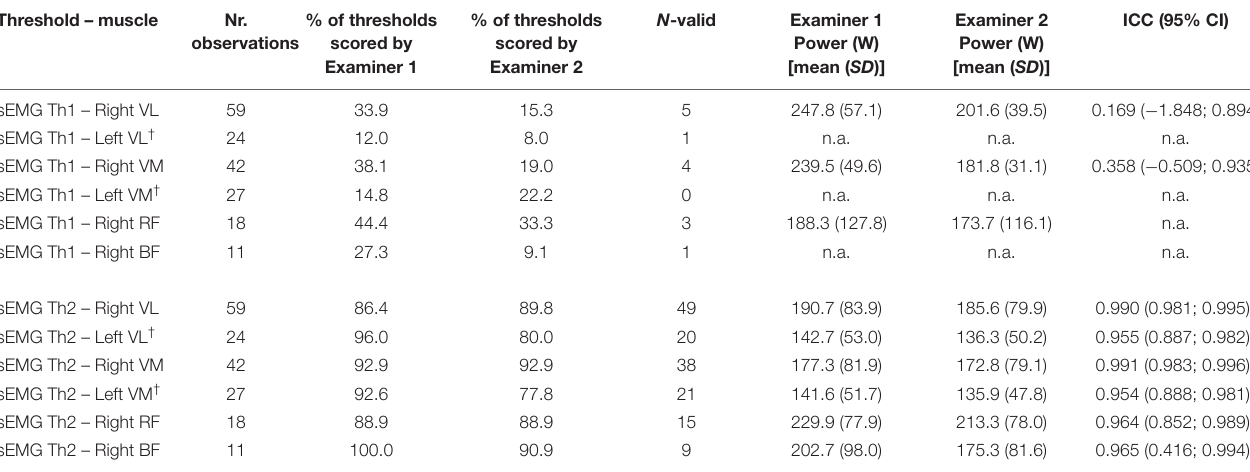
sEMG Th1, first surface EMG threshold; sEMG Th2, second surface EMG threshold; VL, vastus lateralis; VM, vastus medialis; RF, rectus femoris; BF, biceps femoris. † Left VL and left VM are only measured in NMD patients and not in healthy controls. *Statistically significant p-value < 0.05.